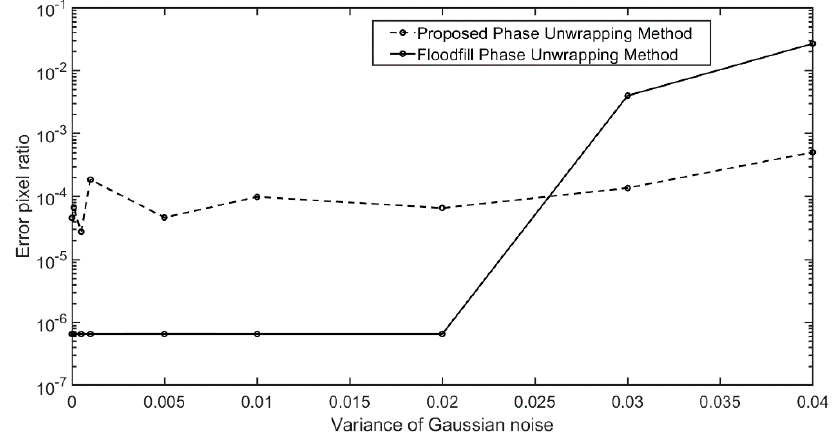
ff erent Gaussian